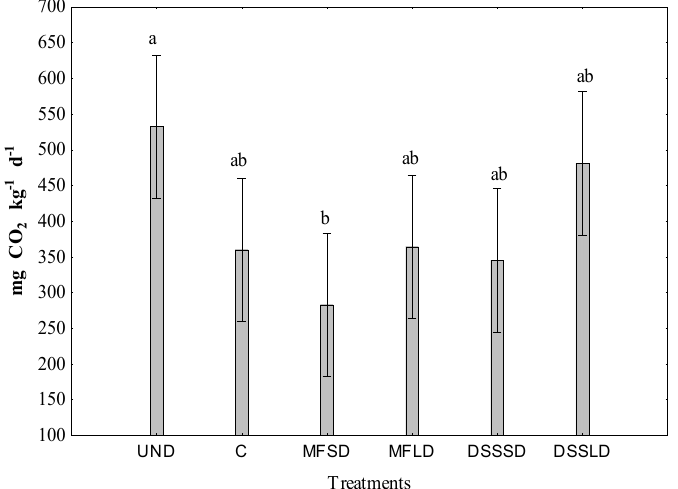
Figure 4. Respiratory activity in soil 1 year after amendment application. Explanations: UND–undisturbed native vegetation, C–control soil without mineral and organic fertilization, MFSD–mineral fertilization amendment, small dose, MFLD–mineral fertilization amendment, large dose, DSSSD–dairy sewage sludge, small dose, DSSLD–dairy sewage sludge, large dose, n = 3. Vertical error bars represent the standard error of the mean.